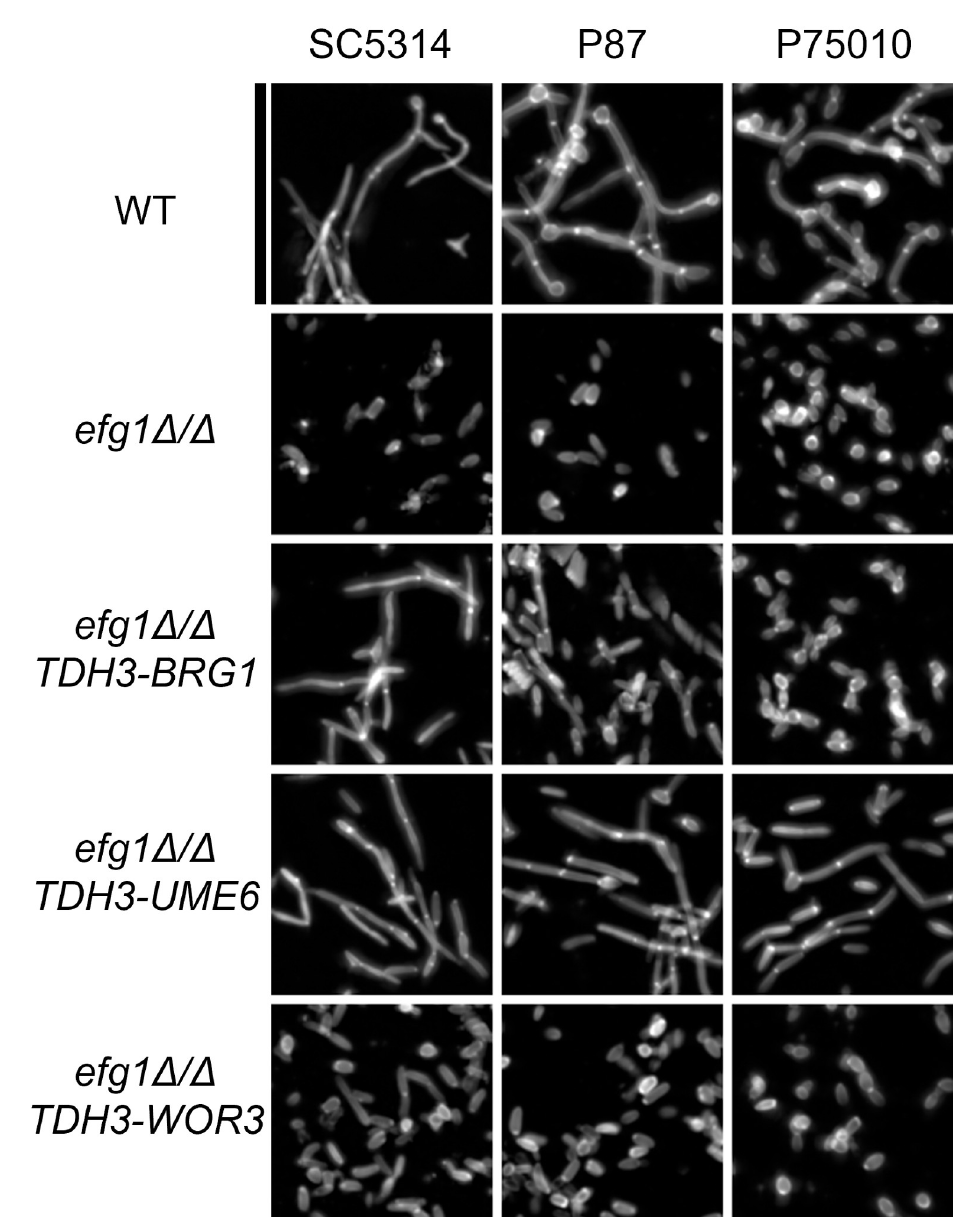
Fig 5. Rescue of efg1 Δ / Δ hypha formation. Fluorescence image of SC5314, P87, and P75010 wild-type (WT), efg1 Δ / Δ , efg1 Δ / Δ TDH3-BRG1 , efg1 Δ / Δ TDH3-UME6 , and efg1 Δ / Δ TDH3-WOR3 strain planktonic hypha formation in RPMI +10%FBS 37˚C for 4hrs. Samples were fixed in 4% formaldehyde in 1X PBS and stained with Calcofluor-white. Scale bar indicates 80 μ